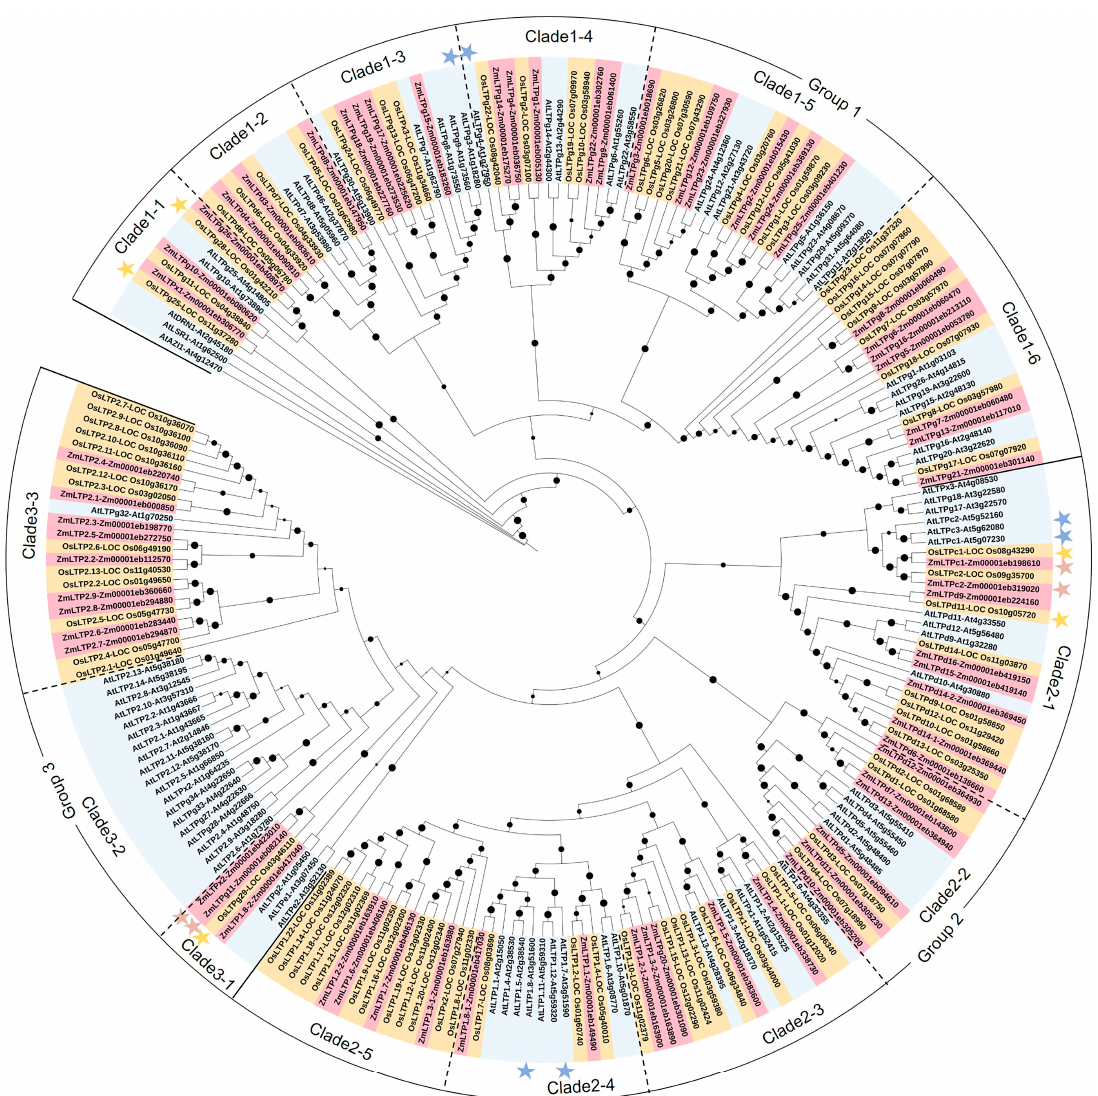
Figure 2. Phylogenetic analysis of LTPs in maize (65), rice (80), and Arabidopsis (84). Group 1 can be further classified into six clades (Clades 1 ‐ 1 to 1 ‐ 6), which contains 91 LTPs, including 28 in maize, 31 in rice and 32 in Arabidopsis . Group 2 can be further classified into five clades (Clades 2 ‐ 1 to 2 ‐ 5), which contain 89 LTPs, including 25 in maize, 35 in rice, and 29 in Arabidopsis . Group 3 can be further classified into three clades (Clades 3 ‐ 1 to 3 ‐ 3), and contains 91 LTPs, including 28 in maize, 31 in rice, and 32 in Arabidopsis . Gray, yellow, and violet background represent the LTPs in Arabidopsis , rice, and maize; and gray, yellow, and violet asterisks represent the male fertile genes in Arabidopsis , rice, and maize, respectively. The dark spots on the branches of the tree indicate the evolutionary distance; the larger dark spot means the closer evolutionary distance of LTPs.